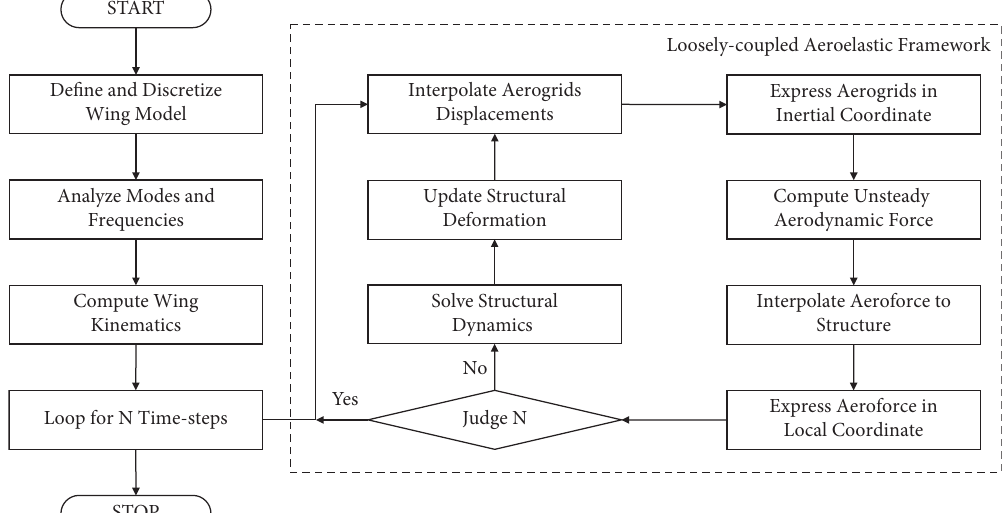
Figure 7: A schematic of the aeroelastic framework for fluid-structure